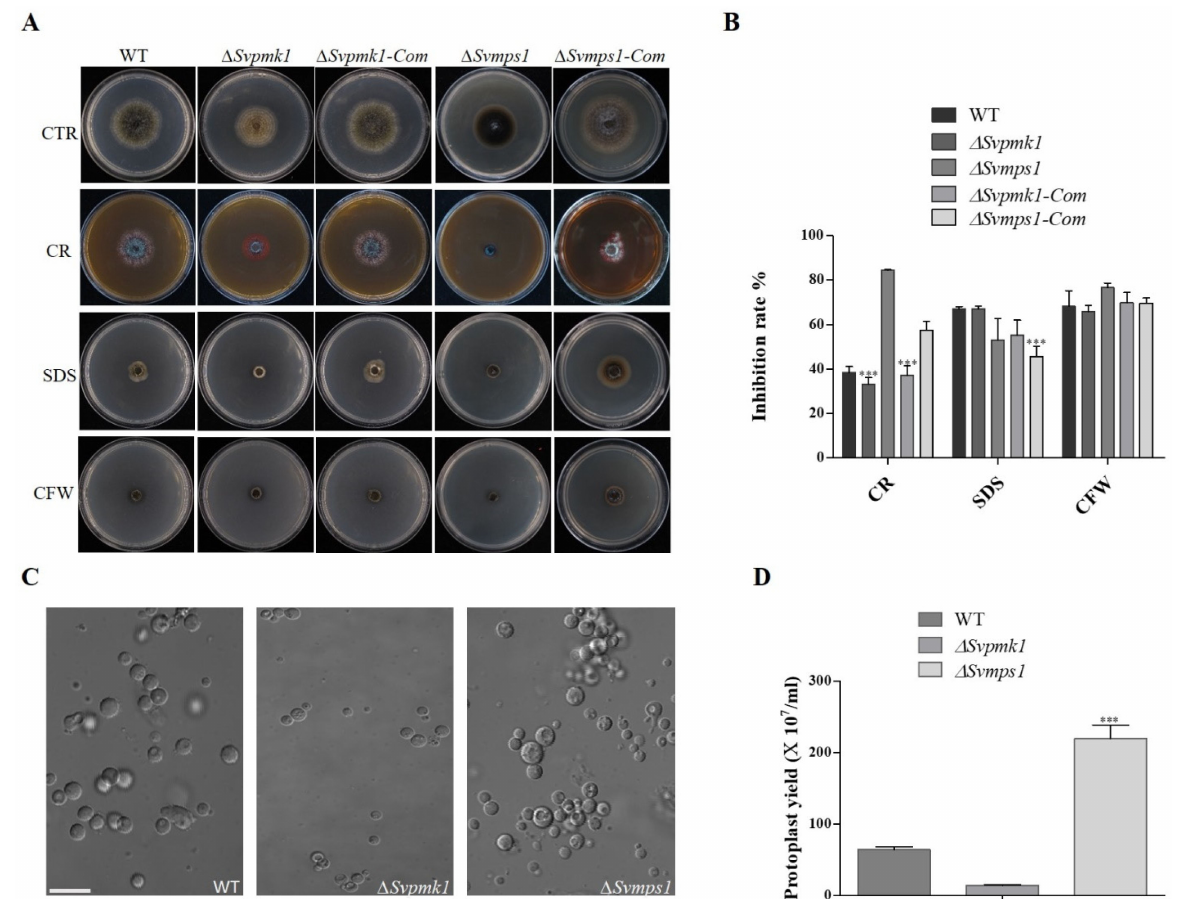
Figure 4. Sensitivity of ∆ Svpmk1 , ∆ Svmps1 and their complemented strains to cell wall stressors. ( A ) Vegetative growth of the WT, mutant and complemented strains cultured on PDA supplemented with the cell wall stressors (200 µ g/mL CR, 0.01% SDS and 200 µ g/mL CFW) and imaged 7 dpi. ( B ) Percentage growth inhibition of the WT, ∆ Svpmk1 , ∆ Svmps1 and complemented strains on CR, SDS and CFW. ( C ) Protoplasts from the WT, ∆ Svpmk1 and ∆ SvMps1 after treatment with lysing enzyme at 30 ◦ C 85 rpm for 2 h. Error bar = 10 µ m. ( D ) Amount of protoplast released by the WT and the two mutant strains. The inhibition rate of each treatment was compared with the growth rate of the untreated control. Inhibition rate = (the colony diameter of untreated strain—the colony diameter of the treated strain)/the colony diameter of untreated strain) × 100. Asterisk = p -value ***, p < 0.0001). Statistical analysis was conducted using two-way ANOVA with Tukey’s multiple-comparison test (GraphPad Prism 5). Error bar represents standard deviation from the mean. The experiments were conducted three times with five independent